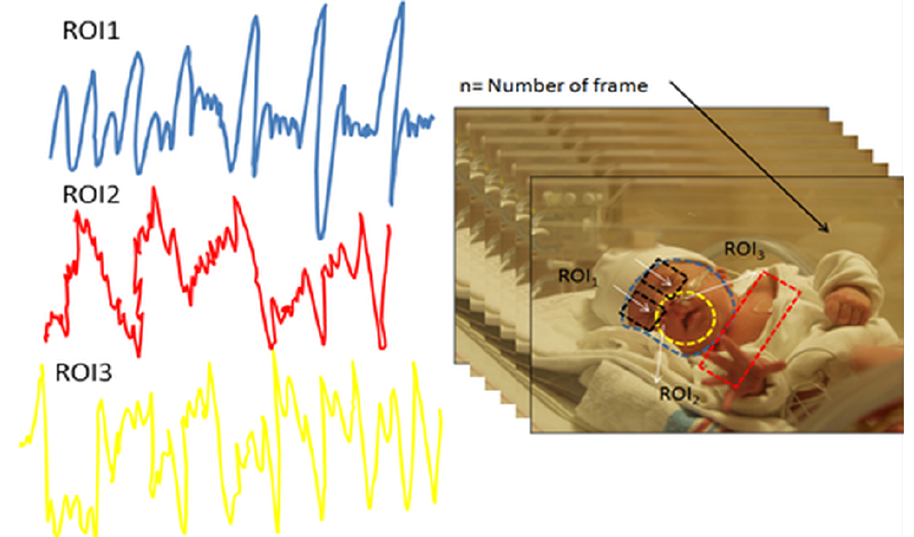
Figure 11. ( Left ) extracted gradient movement from defined regions of interest (ROIs) based on color intensity variation in successive video frames; ( Right ) video frame series of the neonate inside the incubator with three defined ROI profiles over forehead, nose, and